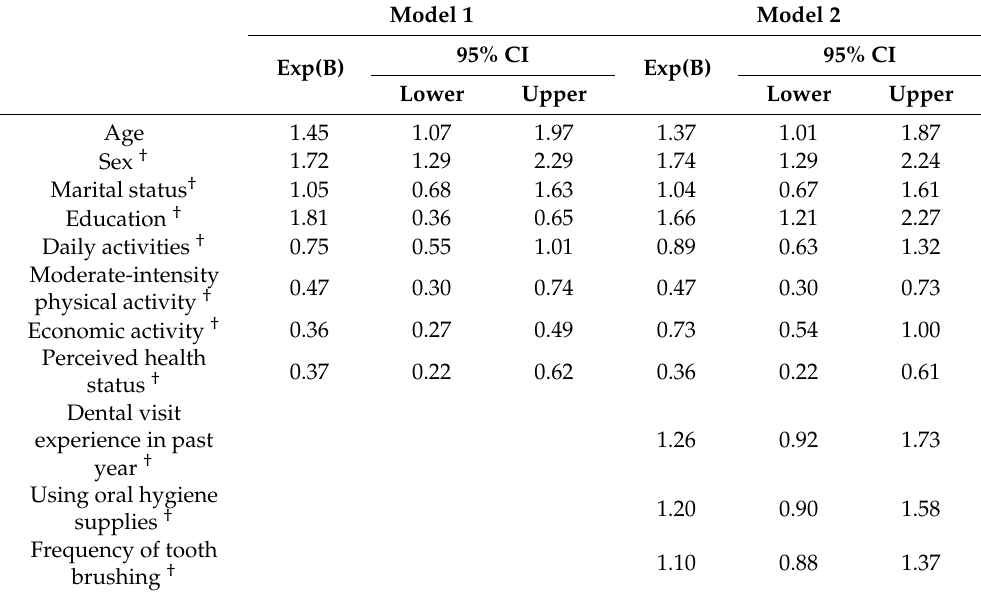
Table 3. Predictors of basic livelihood recipient with depression ( N =